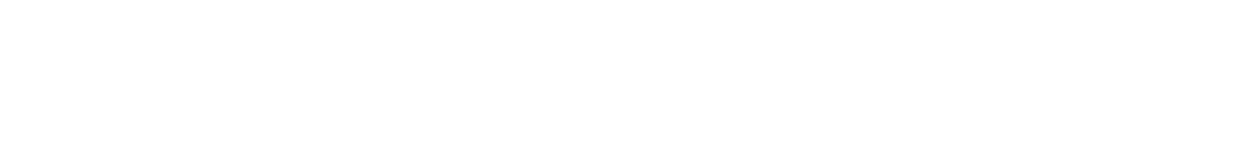
Frontiers in Genetics |